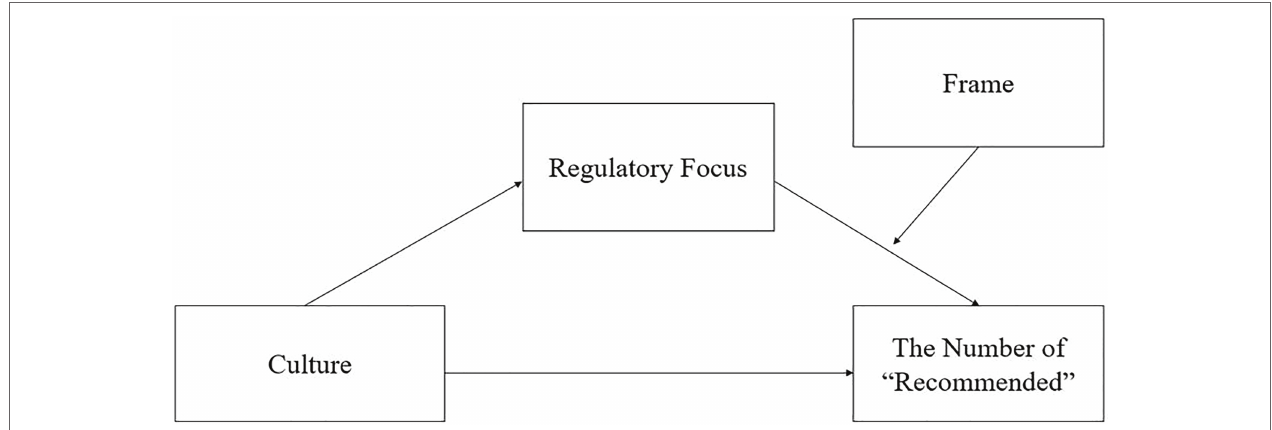
FIGURE 1 | Moderated mediation model to be